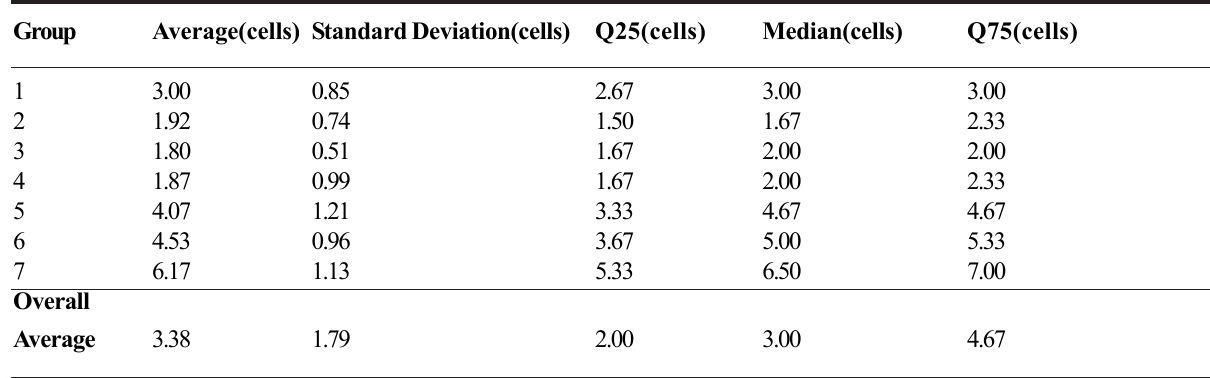
TABLE 5 – Measures of giant cells (cells), with Arithmetical Average, Standard Deviation, Q25, Median, Q75 of all Groups, individually and globally.